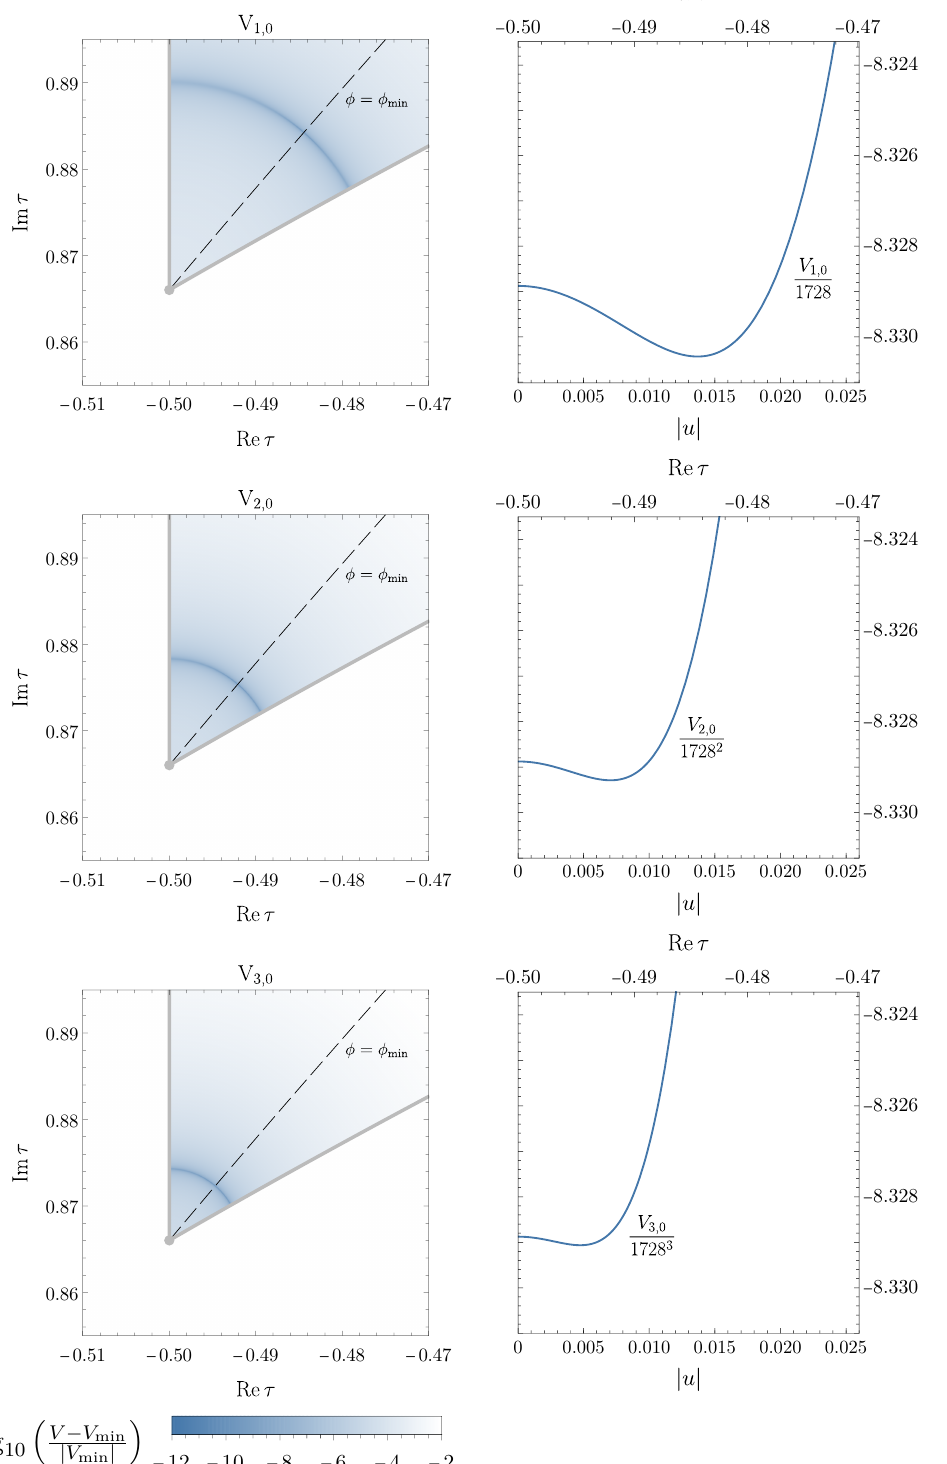
Figure 4 . Potentials V m, 0 ( τ, ¯ τ ) , m = 1 , 2 , 3 , in the vicinity of the cusp (left panel) and their 1- dimensional projections onto the curve φ = φ